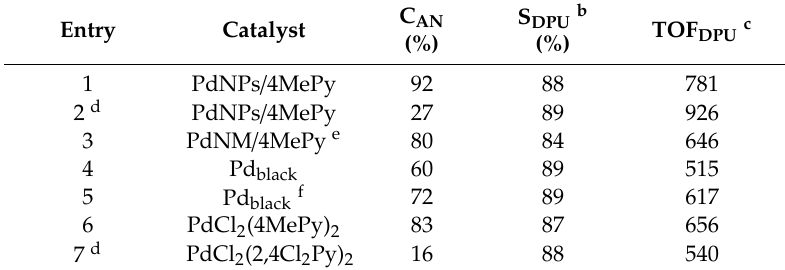
Table 3. Parameters obtained for the carbonylation of aniline by CO / CO 2 / O 2 : conversion (C AN ), selectivity (S DPU ) and turnover frequency (TOF DPU ), depending on the catalyst a . C AN S DPU b Entry Catalyst TOF DPU c (%) (%) 1 PdNPs / 4MePy 92 88 781 2 d PdNPs / 4MePy 27 89 926 3 PdNM / 4MePy e 80 84 646 4 Pd black 60 89 515 5 Pd black f 72 89 617 6 PdCl 2 (4MePy) 2 83 87 656 7 d PdCl 2 (2,4Cl 2 Py) 2 16 88 540 Reaction conditions unless stated otherwise: Pd-based catalyst / Fe / I 2 = 0.056 / 0.5 / 0.12 mmoL, AN = 54 mmoL, 1.5 MPa CO, 1.9 MPa